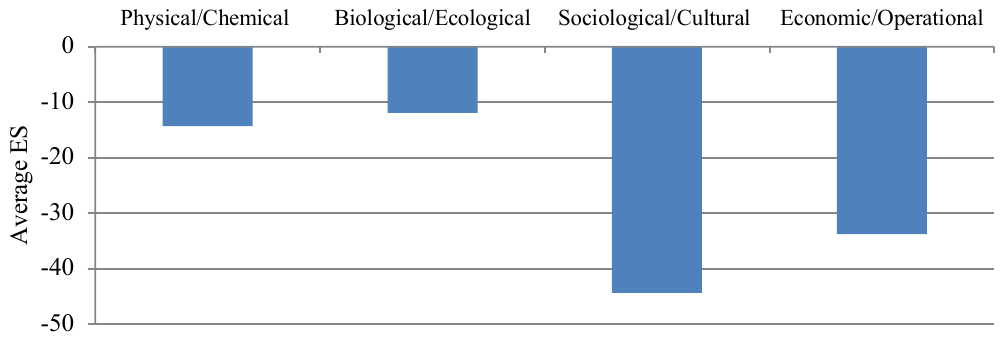
Figure 10. Average Environmental score of marginalized in